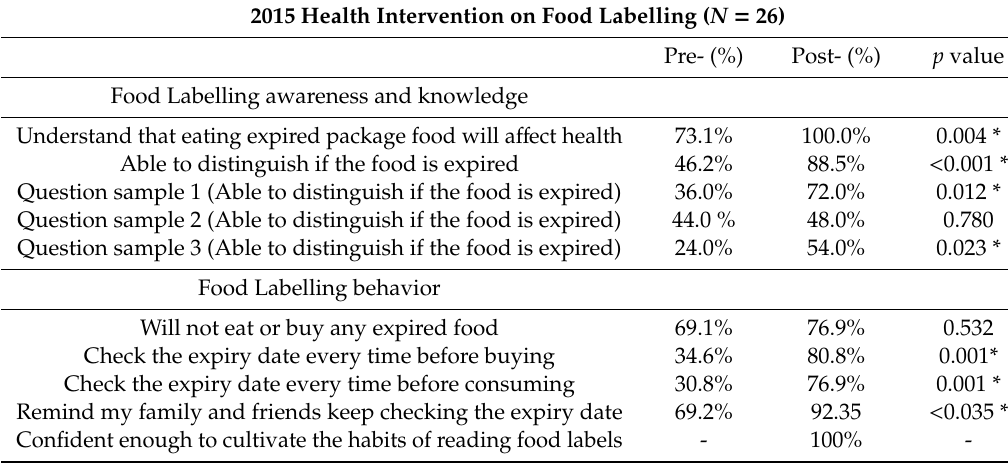
Table 4. Key findings on the e ff ectiveness of pre-and post-intervention in the 2015 Food Labelling. 2015 Health Intervention on Food Labelling ( N =